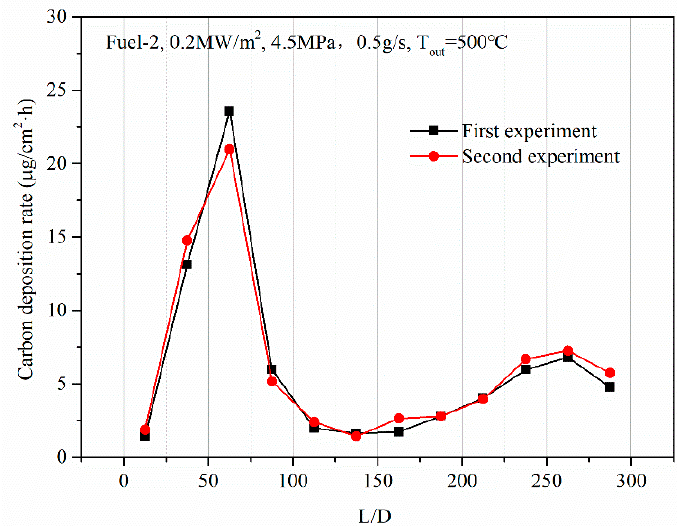
Figure 2. Comparison of repeatability test results (Case 5).